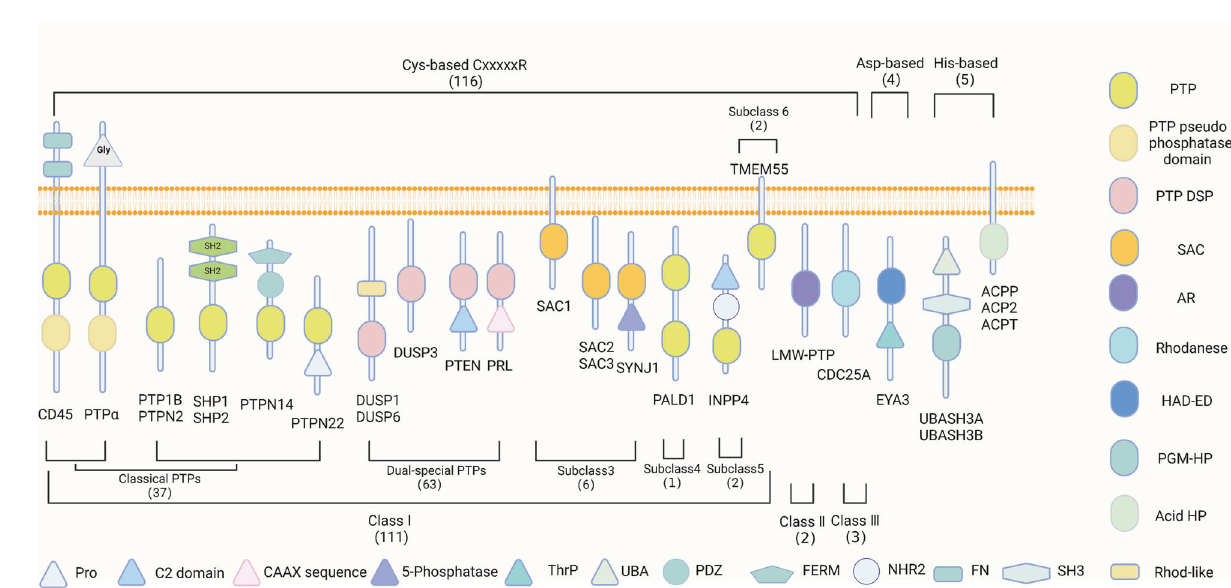
Fig. 1 A growing tyrosine phosphatase family. Tyr phosphatases are classi fi ed based on their nucleophilic catalytic residue (Cys, Asp, or His). The representative schematic depiction and domain composition of the members in each group is shown. Cys-based PTPs contain the signature motif CxxxxxR with 3 classes and 6 subclasses. SAC phosphoinositide phosphatases and PTP-like phytases (PTPLPs) (PALD1/paladin), sharing the PTP fold, have been included in the class I Cys-based group as subclasses III and IV. INPP4 phosphatases (subclass V) and